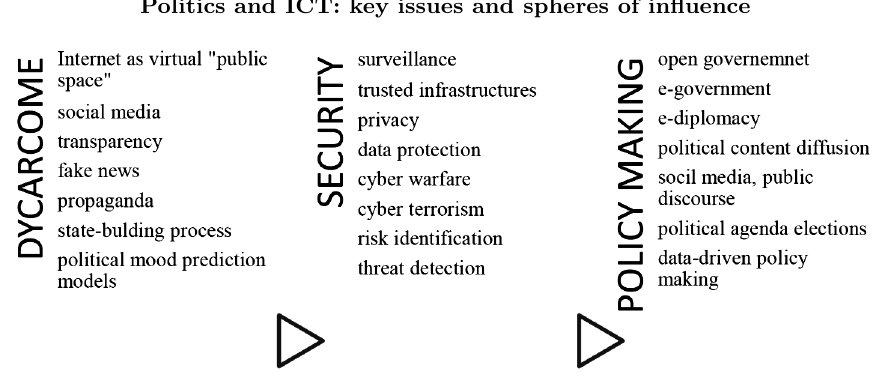
Politics and ICT: key issues and spheres of